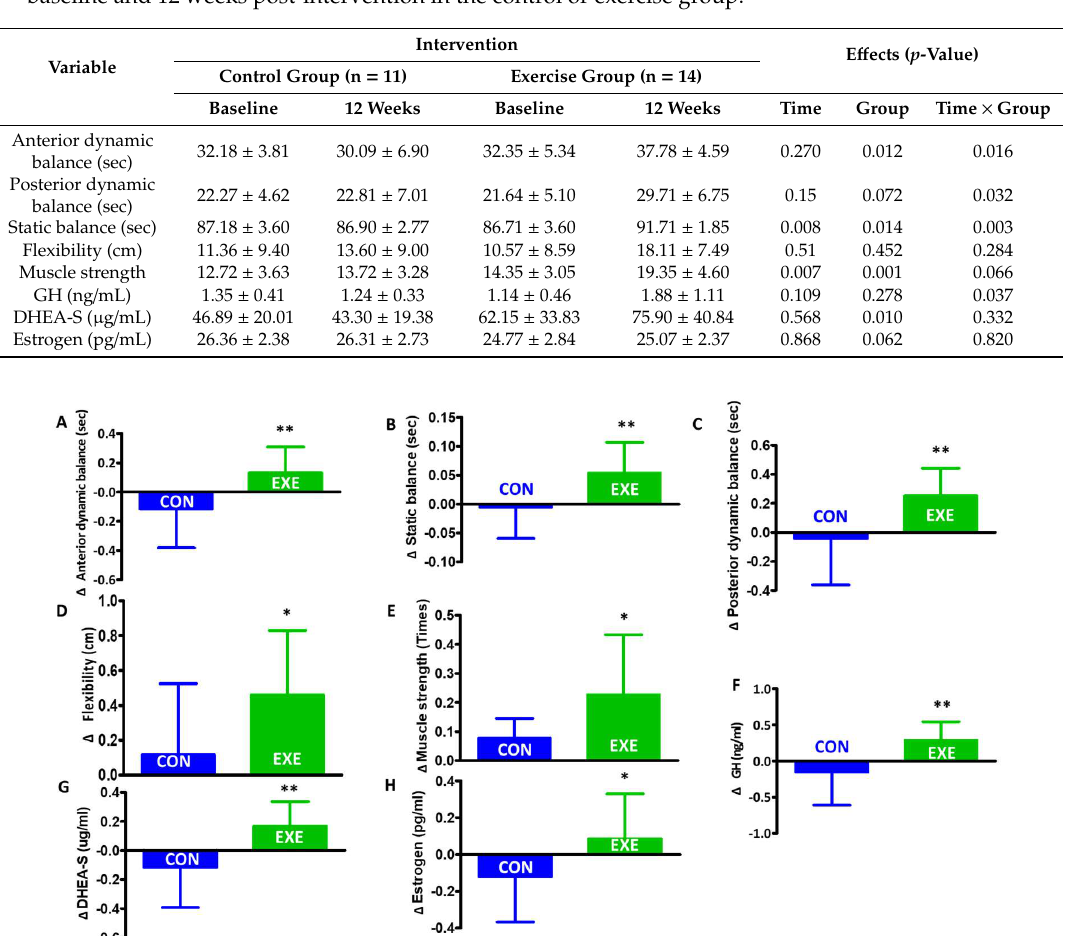
Table 3. Participants’ anterior dynamic balance, posterior dynamic balance, static balance, flexibility, muscle strength, growth hormone (GH), dehydroepiandrosterone-sulfate (DHEA-S), and estrogen at baseline and 12 weeks post-intervention in the control or exercise group.